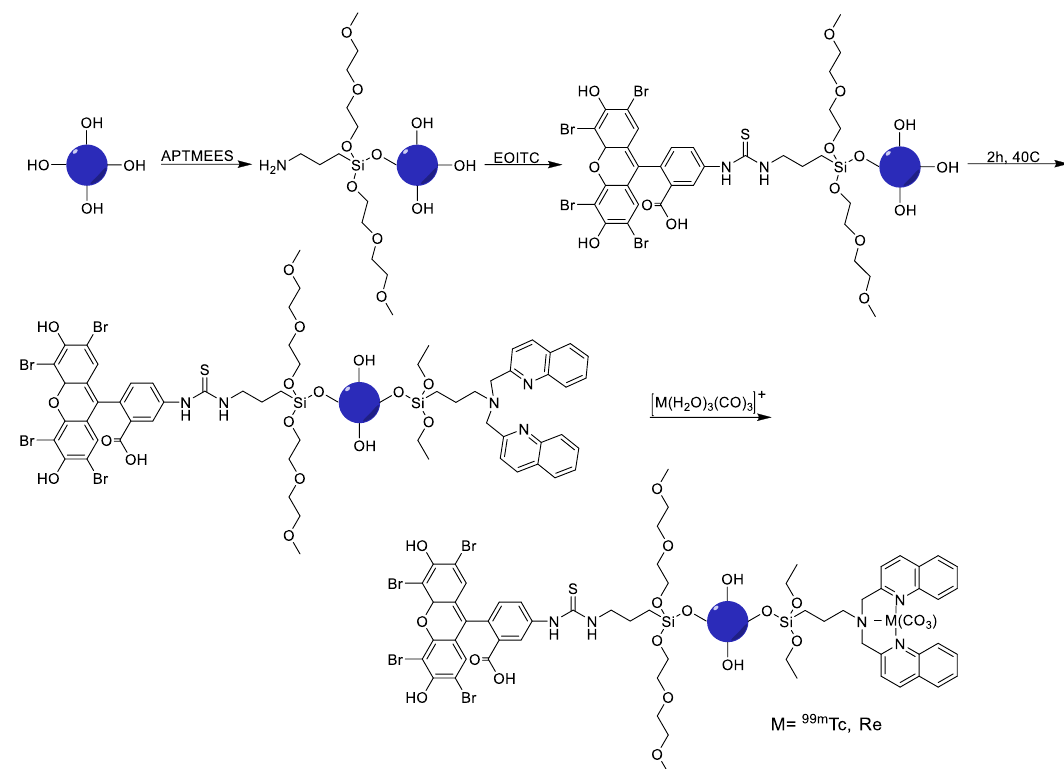
Figure 9. Synthesis of multifunctional mesoporous silica nanoparticles (SBA-15). Step 1: installation of APTMEES at room temperature, Step 2: conjugation of eosin isothiocyanate (EOITC) fluorescent dye, Step 3: conjugation of 99m Tc/ 188 Re chelator, Step 4: radiolabeling with 99m Tc or 188 Re [55].